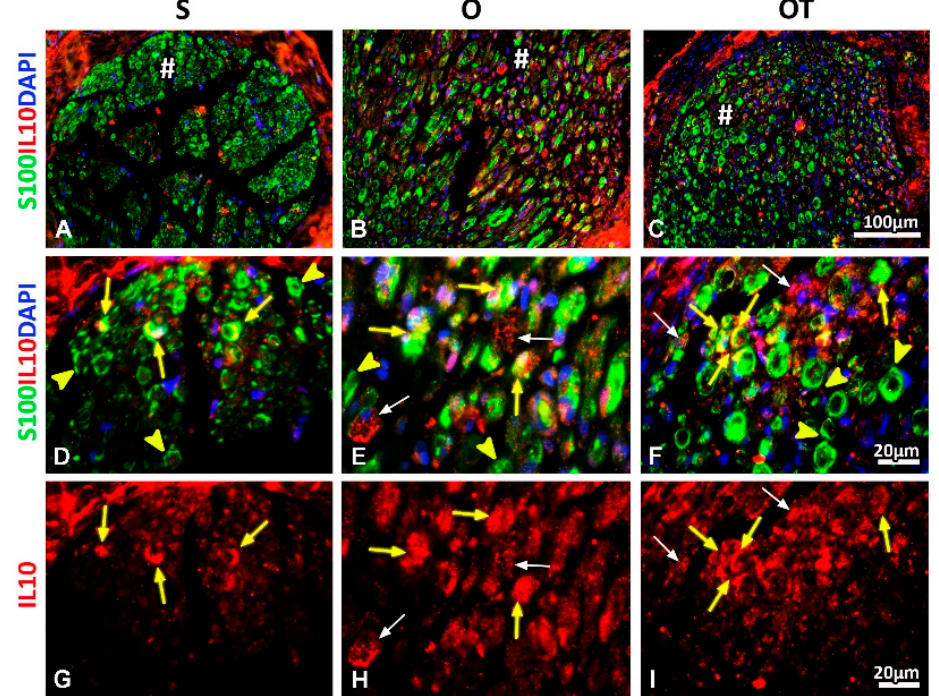
Figure 8. Effects of PNI and the B vitamins treatment on expression of anti-inflammatory cytokine interleukin 10 (IL-10) in SCs. Cross sections of the femoral nerve obtained from the: sham (S), operated (O) and operated and treated with the vitamin B (B1, B2, B3, B5, B6, and B12) complex (OT) group immunostained for IL-10 (red) showed strong IL-10 immunoreactivity in all of the groups ( G , H , and I ) at the 14th dpo, being the most pronounced in the O group ( H ). Increased IL-10 immunoreactivity was found in S100 + (green) myelinating SCs ( E and F , yellow arrows) and in IL-10 + macrophages with the M2-like morphology ( E , F , H , and I , white arrows) that were closely associated to them. In the OT group, the larger part of S100 + SCs was IL-10 − ( F , yellow arrow heads). The similar pattern of IL-10 immunoreactivity was seen in the S group, although IL-10 + / S100 + cells were less represented ( D and G , yellow arrows and yellow arrow heads). DAPI (blue) was used to visualize cell nuclei. # indicates where the high magnification micrographs were taken from. Scale bars: A – C = 100 µ m, D – I = 20 µ m. Using serial transversal sections we were able to visualize tight interactions between M2-macrophages and SCs, that were aligned to form bands of Büngner (Figure 9A–C) and